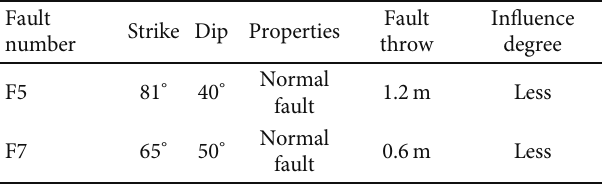
Table 1: Fault data of the 1101 coalface.